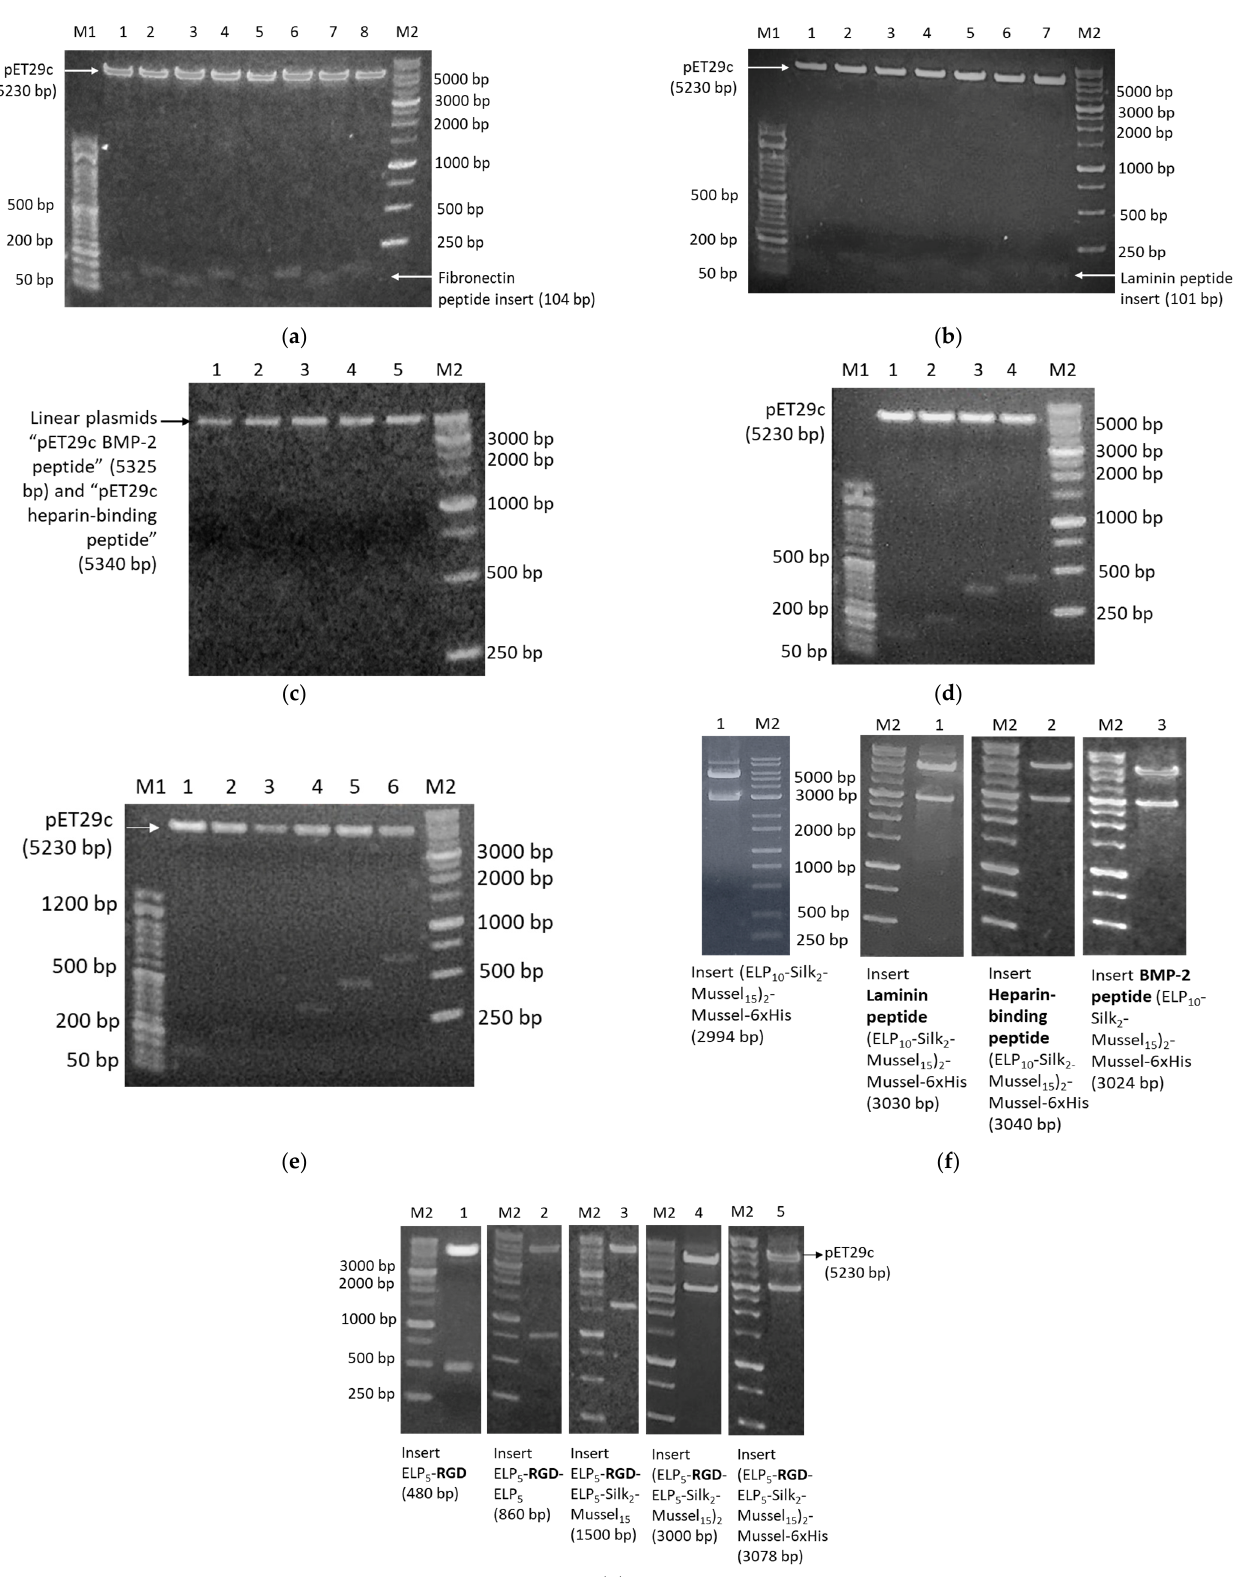
Figure 1. Step-by-step synthesis of recombinamer genes. ( a – c ) Electrophoresis in 1% w / v agarose gels of the recombinant plasmids containing building block sequences after digestion with NdeI and XhoI ( a , b ) or BseRI ( c ). In ( c ), lane 1 corresponds to digested pET29c-BMP2 peptide, and lanes 2–5 represent pET29c-heparin-binding peptide. ( d – f ) Step-by-step assembly of ELP 5 and Silk 2 - Mussel 15 . Numbers in brackets state the length of the inserts. ( d ) Lane (1): pET29c-ELP 1 insert (140 bp), lane (2): pET29c-ELP 2 insert (215 bp), lane (3): pET29c-ELP 4 insert (365 bp), and lane (4): pET29c-ELP 5 insert (440 bp). ( e ) Lane (1): pET29c-Silk 1 (164 bp), lane (2): pET29c-Silk 2 (260 bp), lane (3): pET29c-Mussel 3 (260 bp), lane (4): pET29c-Mussel 9 (320 bp), lane (5): pET29c-Mussel 15 (500 bp), and lane (6): pET29c–Silk 2 Mussel 15 (710 bp). ( f ) pET29c–[(ELP 10 -Silk 2 -Mussel 15 ) 2 -Mussel-6xHis] and final plasmids: pET29c–[laminin peptide-(ELP 10 -Silk 2 -Mussel 15 ) 2 -Mussel-6xHis], pET29c–[hep- arin-binding peptide-(ELP 10 -Silk 2 -Mussel 15 ) 2 -Mussel-6xHis], and pET29c–[BMP-2 peptide-(ELP 10 - Silk 2 -Mussel 15 ) 2 -Mussel-6xHis] digested with NdeI/XhoI. ( g ) Step-by-step assembly of final plas- mid pET29c–[ELP 5 -RGD-ELP 5 -Silk 2 -Mussel 15 ) 2 -Mussel-6xHis]. Μ 1: 50 bp DNA ladder and Μ 2: 1 kb DNA ladder. The polypeptides were overproduced and purified from BL21 (DE3) E. coli bacterial cells by Ni-NTA affinity chromatography. All final amino acid sequences are listed in the Supplementary Materials. The predicted molecular weight of the polypeptides was ~90,000 Da, and the corresponding bands after SDS-polyacrylamide gel electrophoresis were observed slightly above the 100-kD protein marker due to their fibrous nature (Fig- ure 2). ( a ) ( d ) Figure 2. Electrophoresis in 10% w / v SDS-polyacrylamide gels of the fractions after overexpression (20 μ L of cell extract per lane) and purification (10 μ g of protein per lane) of the polypeptides from